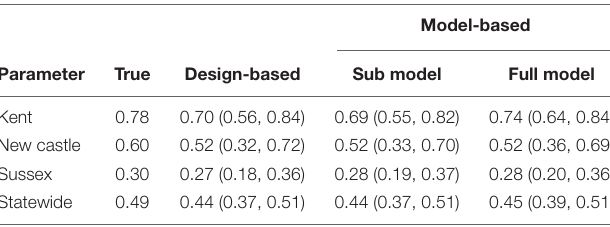
TABLE 3 | County and state-wide proportions of family forest landowners in Delaware, United States, associated with a simulated, non-specific attribute.